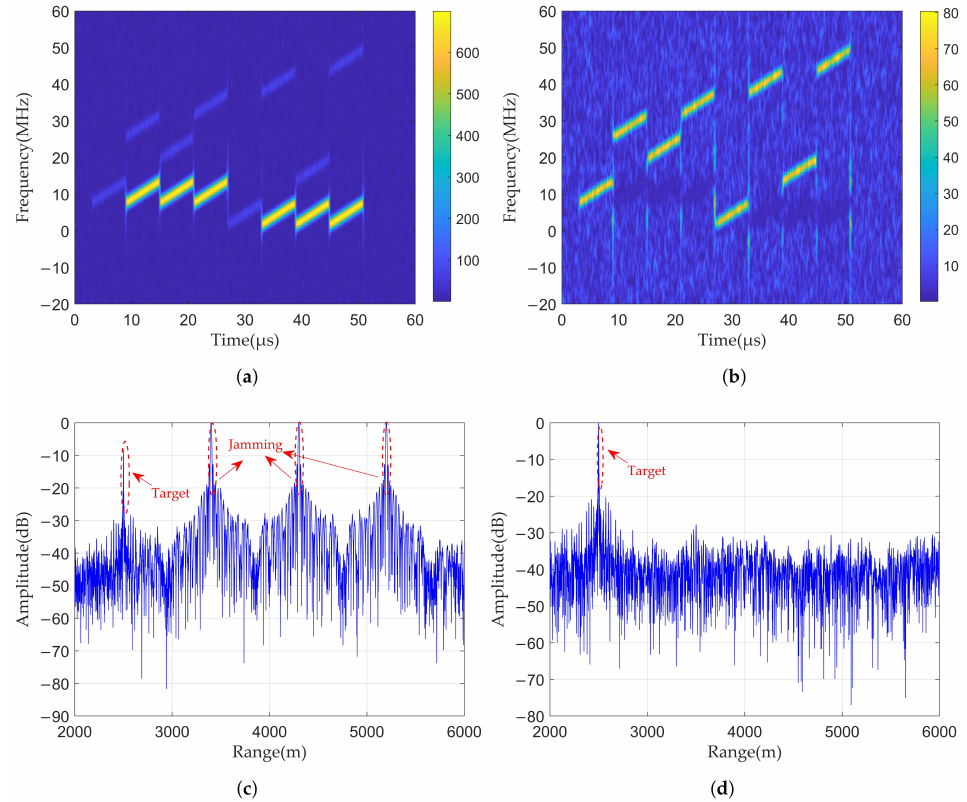
Figure 9. Suppression effect of Ref. [19] on ISRJ: ( a ) time–frequency distribution before suppres- sion, ( b ) time–frequency distribution after suppression, ( c ) pulse compression before suppression, ( d ) pulse compression after